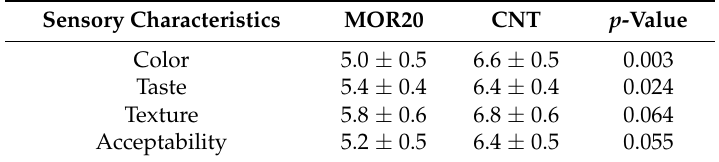
Table 2. Sensory characteristics and overall acceptability of the meals supplemented and not supplemented, with MO leaf powder.